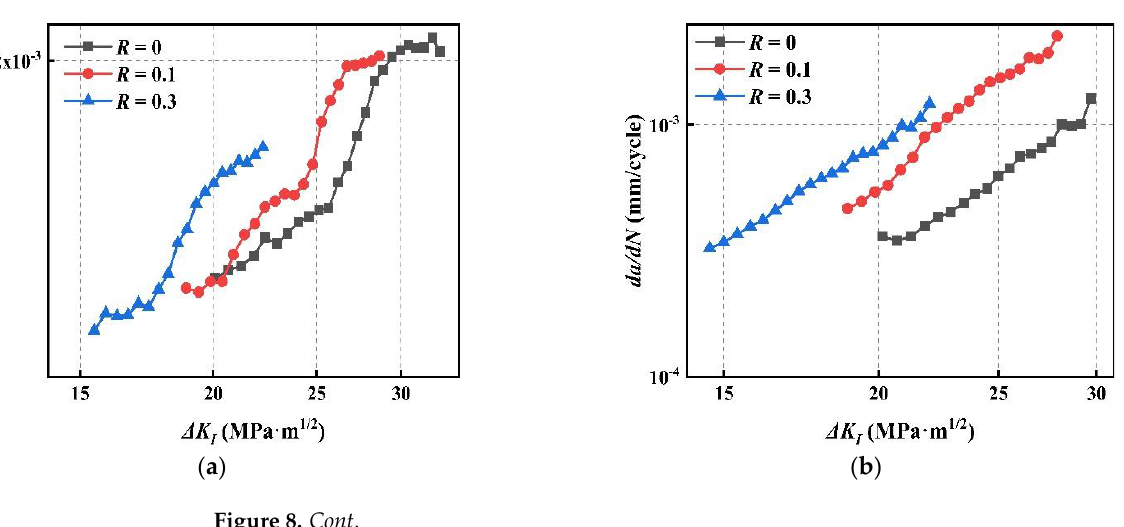
Figure 7. Wher e β = 60°, λ = 0, R = 0.1, the relationship between ∆ K I , ∆ K II and ∆ K v .